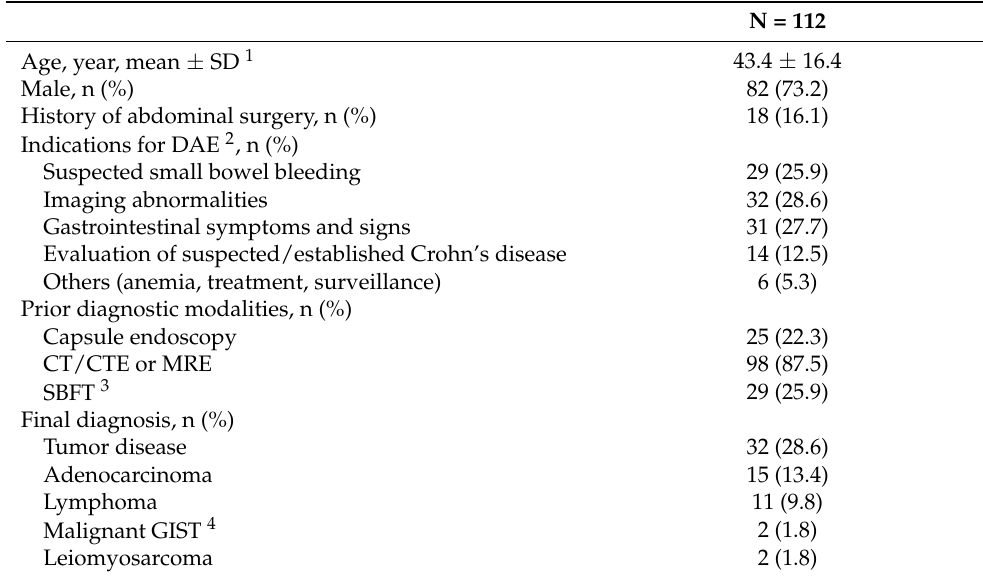
Table 1. Baseline characteristics of the cases and final